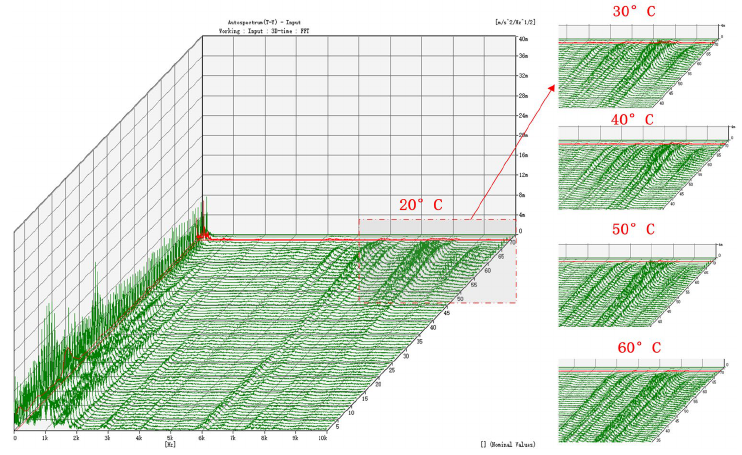
Figure 12. Effect of temperature on the time-frequency diagram of the test bearing in the Y direction.